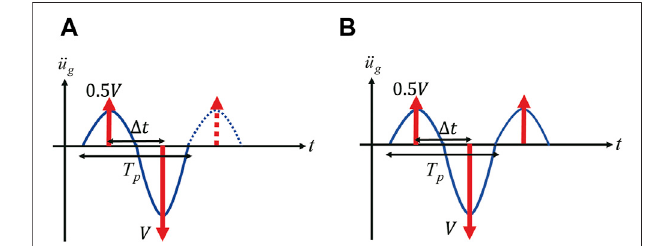
FIGURE 3 | Modeling of rocking rigid block by rigid bar supported by non-linear elastic rotational spring with rigid initial stiffness and negative second slope (Nabeshima et al., 2016).